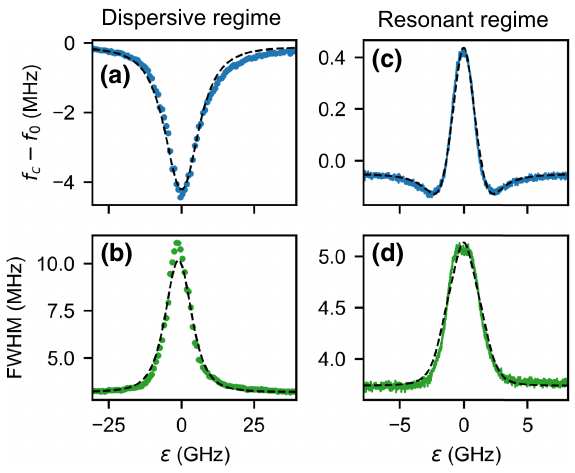
FIG. 5. Quality of model fitting. (a) Blue points plot the shift in the center frequency of the cavity, f c , as the detuning is swept across the ICT in the dispersive regime. (b) Green points plot the change in FWHM of the cavity resonance across the ICT in the dispersive regime. For both (a),(b) the points are extracted from the data shown in Fig. 2(c), and the black dashed line represents the best-fit prediction from the model [see Fig. 2(d)]. (c),(d) Plot of the same quantities for the ICT in the resonant regime (see Fig. 4). For all panels, errors on f c and FWHM are omitted for clarity, and errors on ε are too small to be visible. In (a),(b) the f c and FWHM error bars are too small to be visible, and for (c),(d), the errors are roughly the same magnitude as the random scatter in the points.